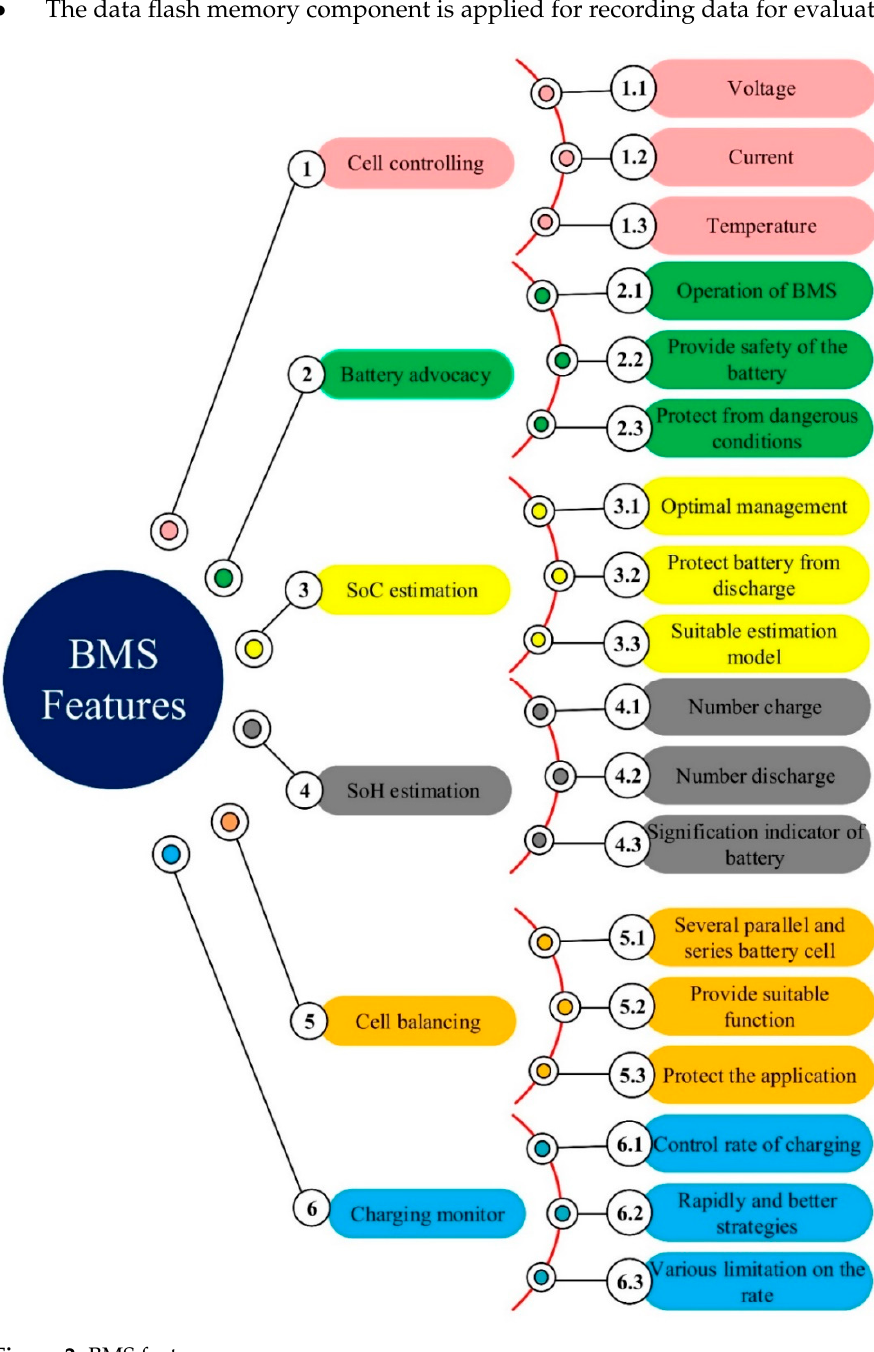
Figure 2. BMS features.